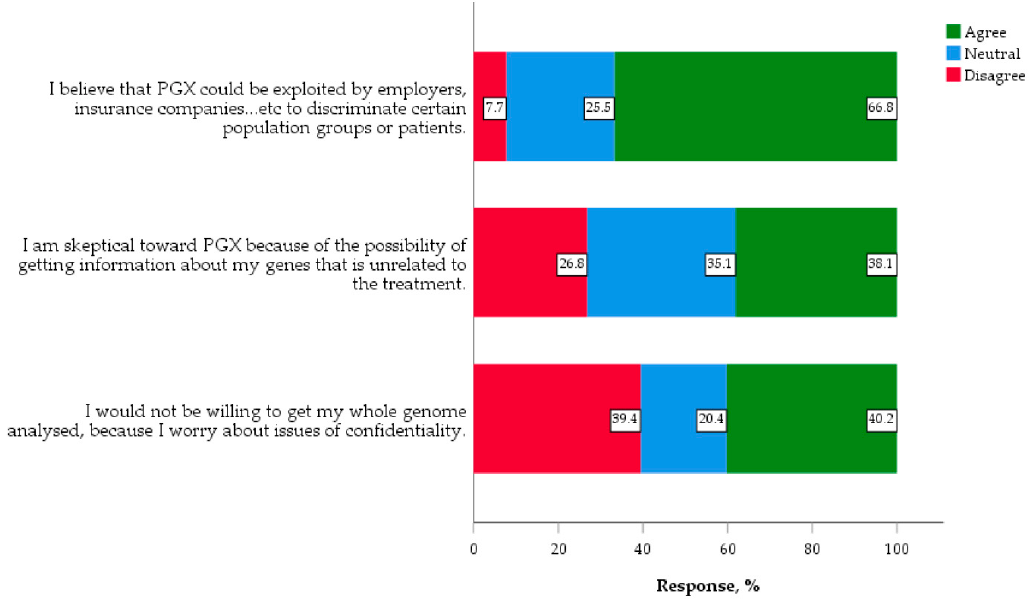
Figure 4. Concerns and ethics regarding genomic medicine and PGX ( n = 388).